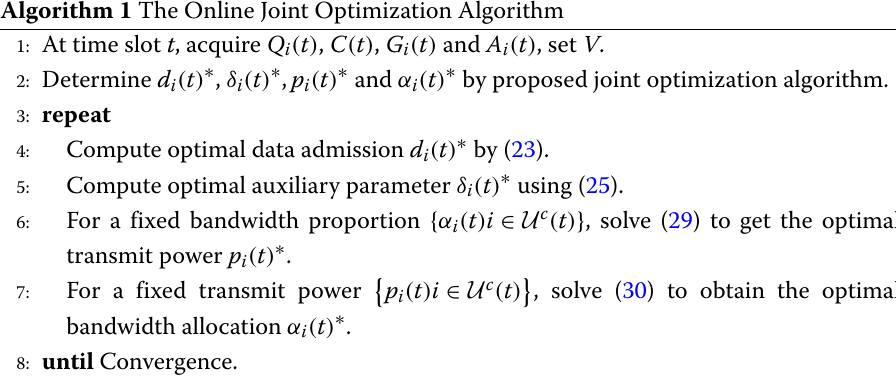
Algorithm 1 The Online Joint Optimization